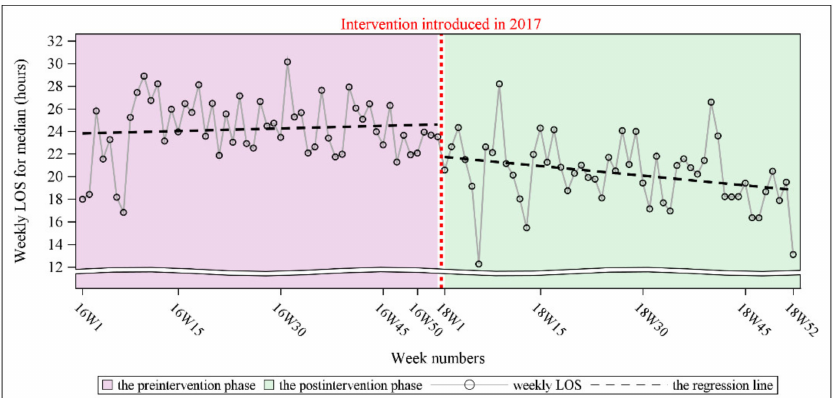
Figure 2. Comparison of weekly LOS for ED admitted patient visits between the preintervention and postintervention phases with fitted segmented regression